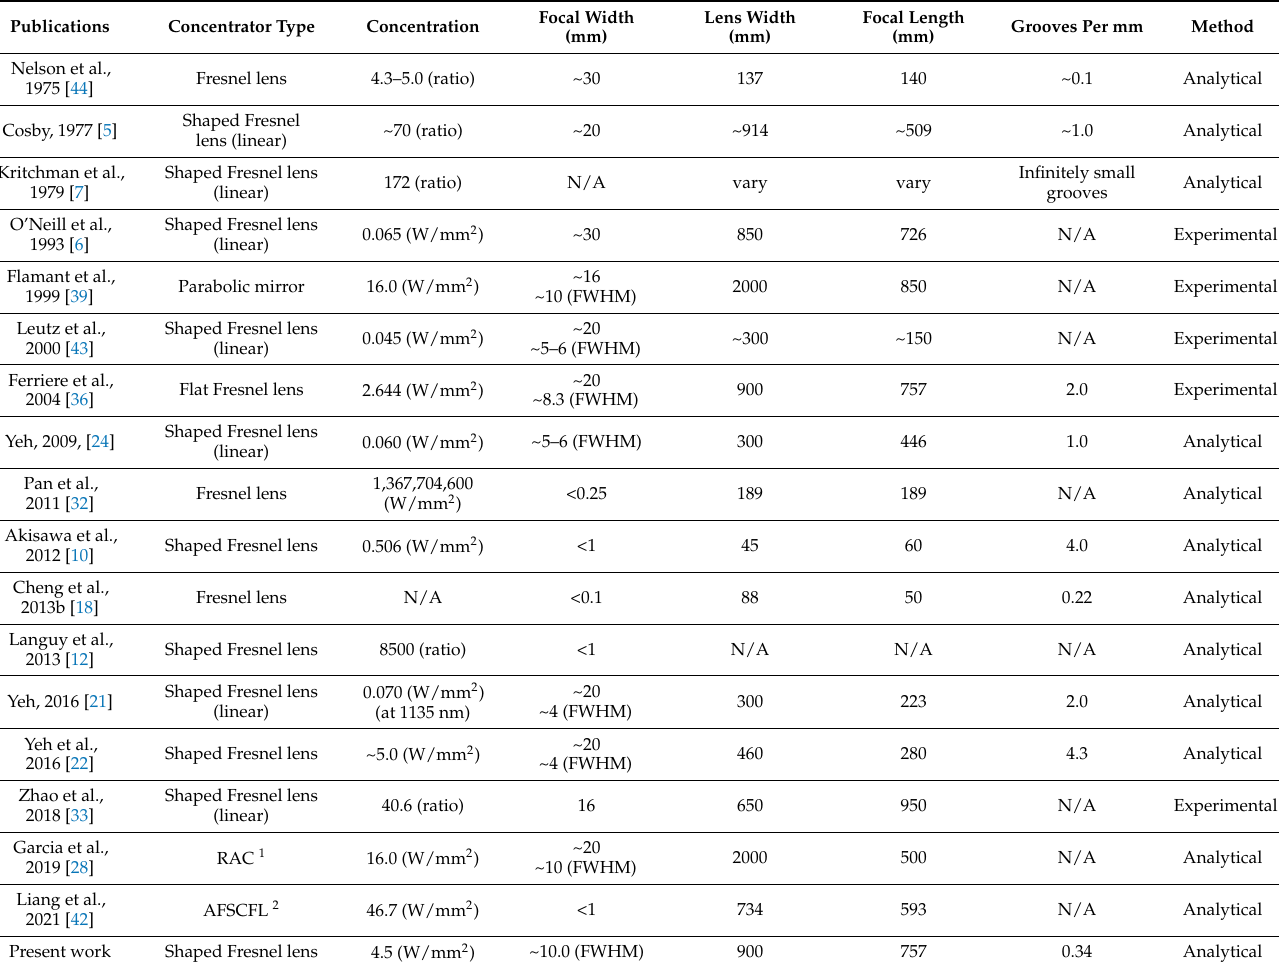
Table 1. Focal concentration and size from various concentrator types found in some